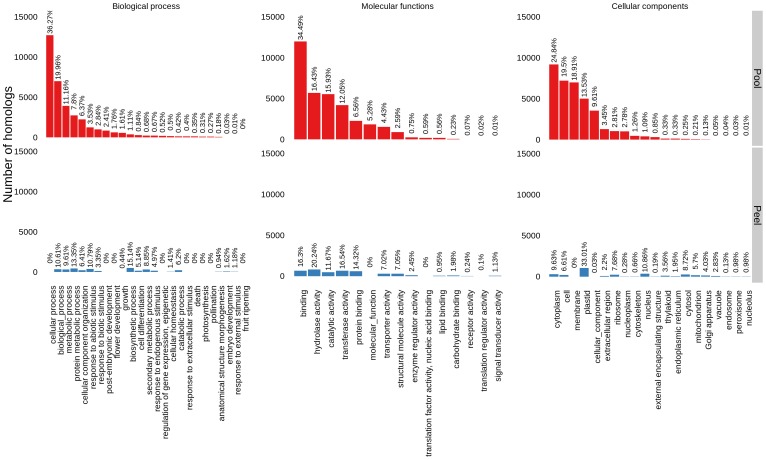
Pomegranate gene ontology categories.Contigs were annotated by blast hits against the nr database and mapped to GO categories by Blast2GO. The distribution of contigs into the GO categories biological processes, molecular functions, and cellular components is plotted for a pool of tissues (root, leaf, flower and fruit developmental stage 3; red bars) and from peel (turquoise bars).